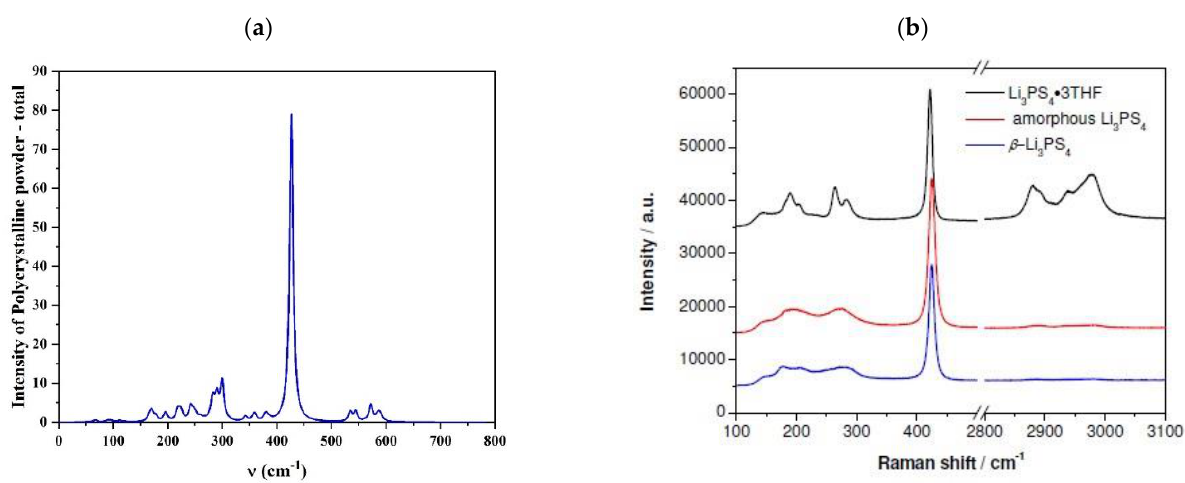
Figure 2. Raman spectra of β - Li 3 PS 4 ( a ) Pn2 1 a crystal computed at the PBE0 level and ( b ) experimental obtained for different samples by Liu and co-workers [5].